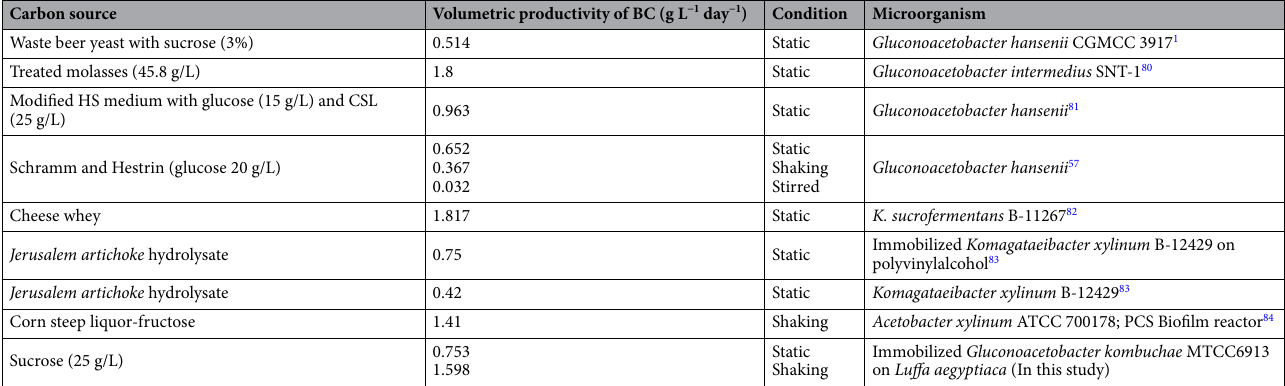
Table 2. Comparison of produced BC using LA support with previous